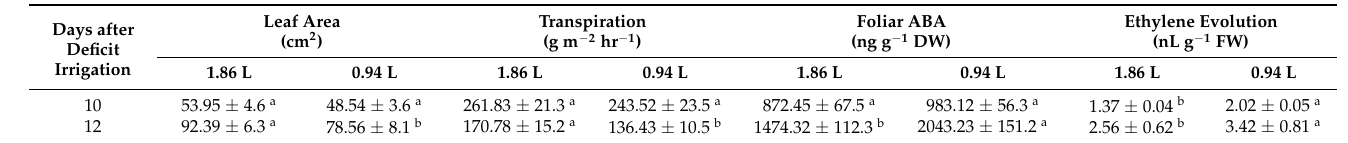
Table 3. Effects of pot size on leaf area, transpiration, and foliar ABA content. Data are means ± standard error (SE). Different letters denote statistically significant differences between treatments ( p < 0.05).